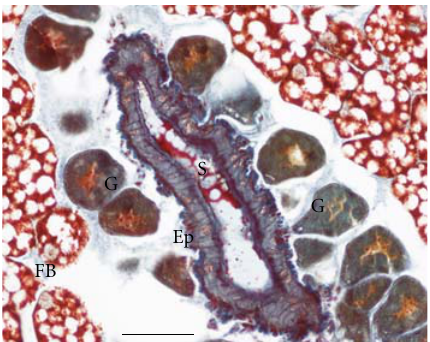
Figure 20: Anterior duct of larval N. abietis salivary gland showing the single layer of epithelial cells (Ep) and secretory products (S) in the central lumen. Gland cells (G) lie in the hemocoel adjacent to the duct and near fat body (FB). Scale bar = 0.1mm.